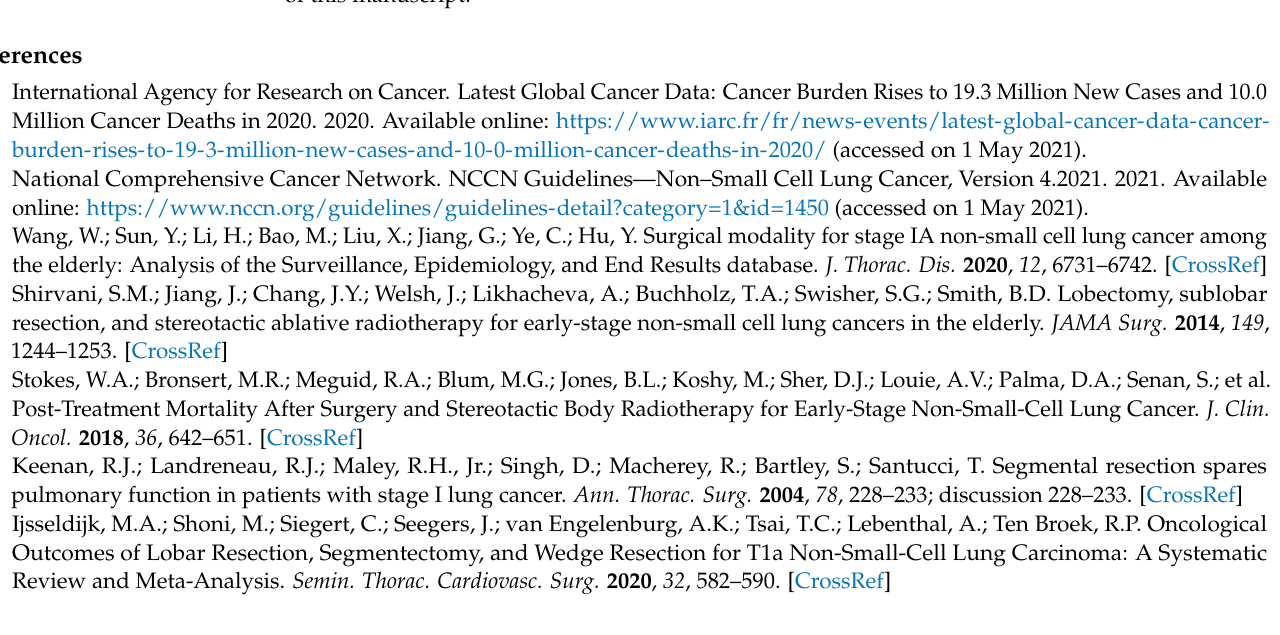
Figure S2: Meta-analyses comparing the distant metastasis risk of sublobar resections with lobec- tomy. OR, odds ratio; Cl, confidence interval. Figure S3: Meta-analyses comparing the recurrence patterns of segmentectomy with wedge resection. OR, odds ratio; Cl, confidence interval. Figure S4: Meta-analyses comparing the operative time (a), blood loss (b), chest drainage day (c), and hospital stay (d) of sublobar resections groups with those of lobectomy group. OR, odds ratio; Cl, confidence interval. Figure S5: Meta-analyses comparing the risk of perioperative morbidities between sublo- bar resection groups and lobectomy group. (a) 30-day mortality; (b) 90-day mortality; (c) overall complications; (d) severe complications; (e) pneumonia; (f) leak complications; (g) cardiac